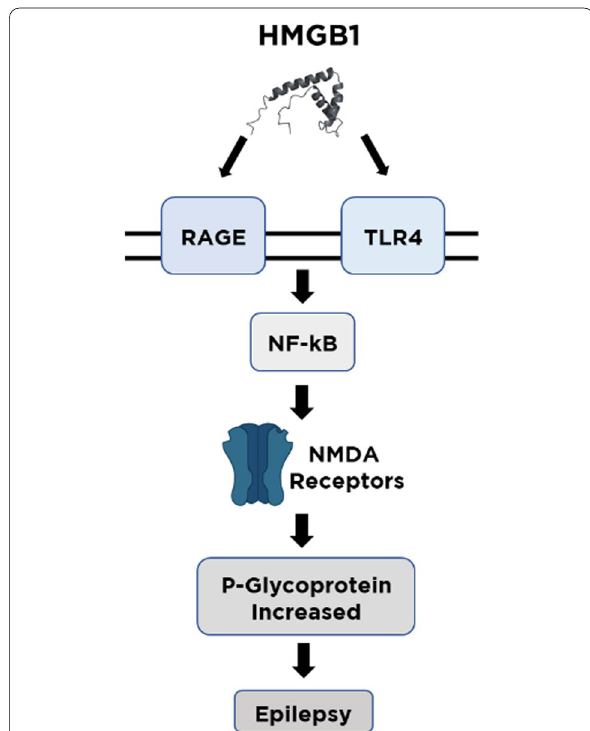
Fig. 1 HMGB1/RAGE/TLR4 pathway signaling. RAGE; receptor for advanced glycation end products, TLR4; toll like receptor 4, NF-kB; nuclear factor kappa B, NMDA; N -methyl-D-aspartic